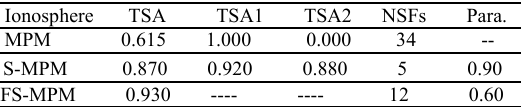
Table 2 TSAs and NSFs for Ionosphere.